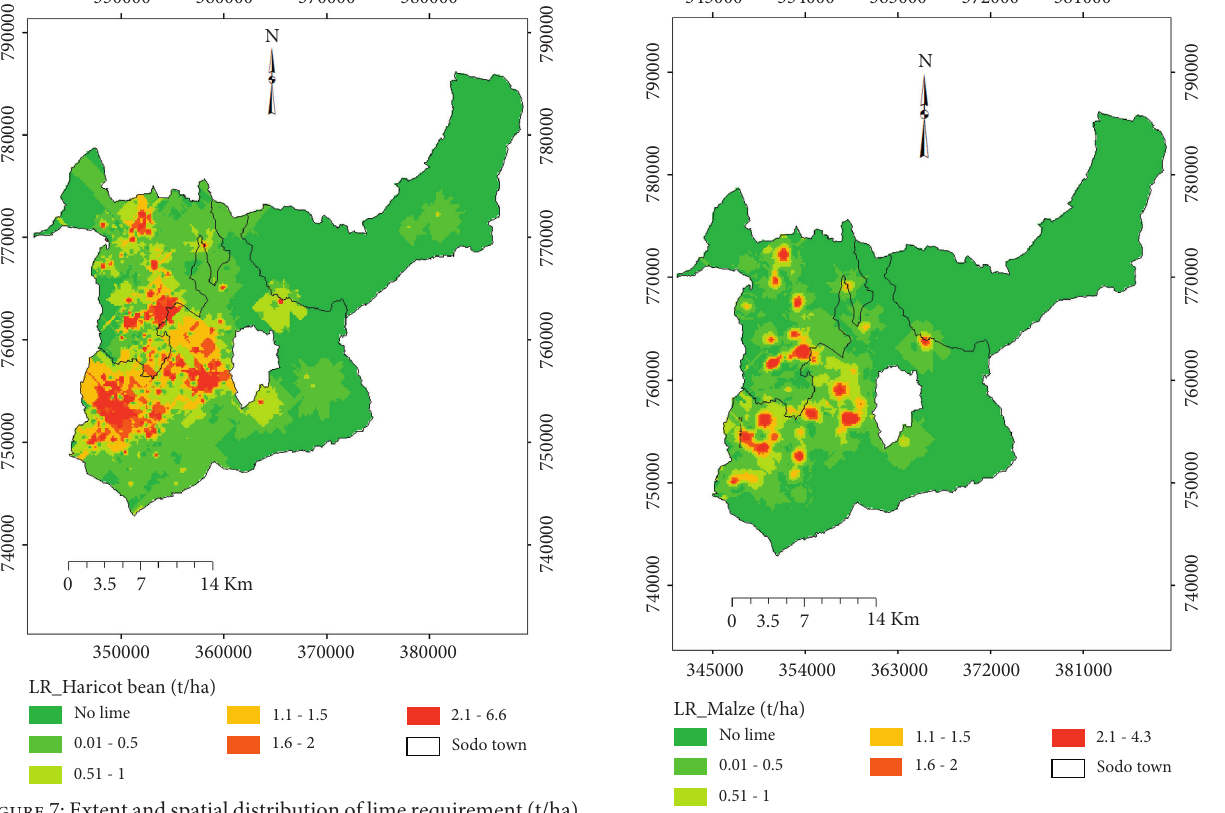
Figure 8: Extent and spatial distribution of lime requirement (t/ha) for maize production across the study